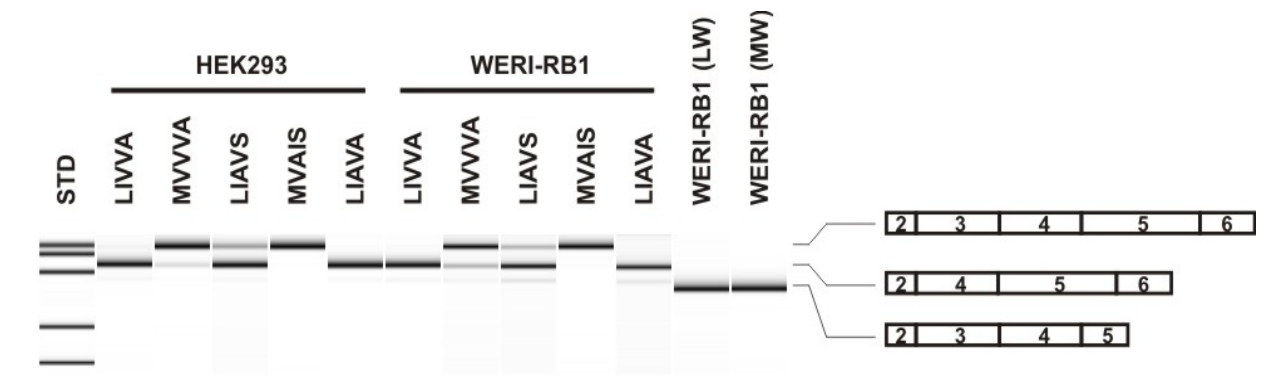
Figure 2. Bioanalyzer separation of RT-PCRs from HEK293 and WERI-Rb1 cells. RT-PCR products obtained with RNA from HEK293 and WERI-Rb1 cells transfected with different exon 3 minigene constructs were separated on a Bioanalyzer DNA-1000 chip. The exonic composition of the products is indicated on the right. RT-PCR products with RNA from non-transfected WERI-Rb1 cells showing expression and correct splicing of endogenous OPN1LW and OPN1MW transcripts were separated in comparison (lanes WERI-Rb1 (LW) and WERI-Rb1 (MW)). Note that different reverse primers were used for amplification of cDNA from minigene transfected cells (i.e., construct-specific reverse primers) and non-transfected WERI-Rb1 cells, which also results in fragment size differences. STD—Size Standard.